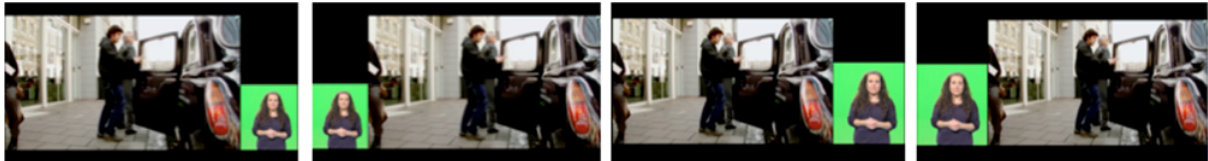
Figure 1. Screen compositions, from left to right: Small/Right; Small/Left; Medium/Right;